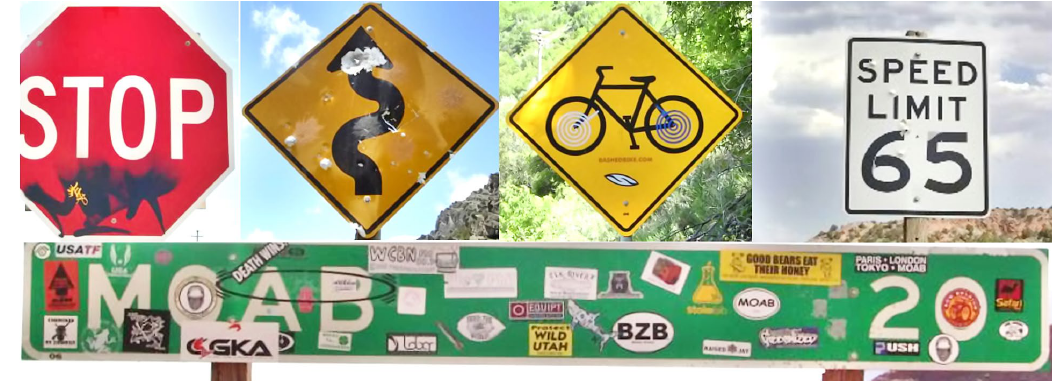
Fig. 2. Samples of traffic sign vandalism (source: photos taken by our research team)